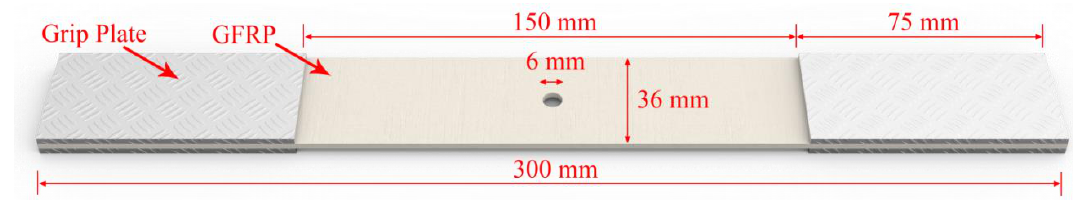
Figure 2. Diagrammatic sketch and geometry of the GFRP laminate